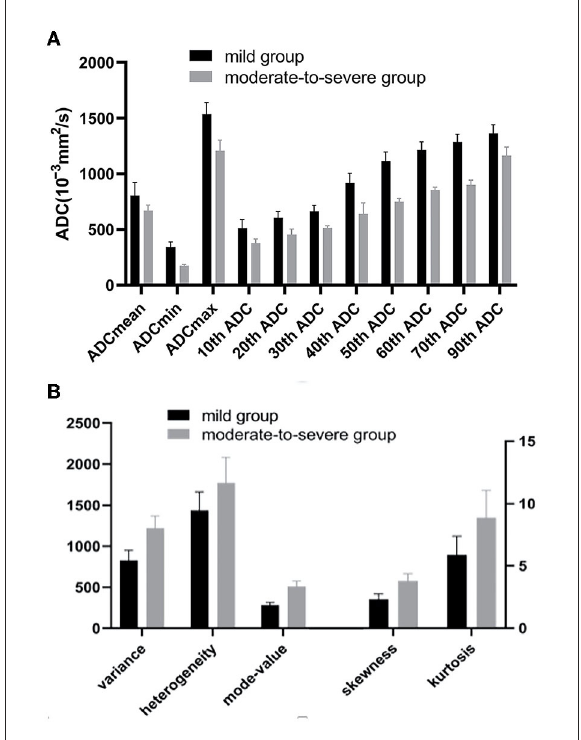
FIGURE2 (A) The ADCmean, ADCmin, ADCmax,10th-70th and 90th percentile of ADC values of the moderate-to-severe group were all lower than that of the mild group ( P < 0.05). (B) The Variance, the skewness, the kurtosis, the heterogeneity, and the mode-value of the moderate-to-severe group were larger than that of the mild group ( P < 0.05). ADC, apparent diffusion coefficients (10 − 3 mm 2